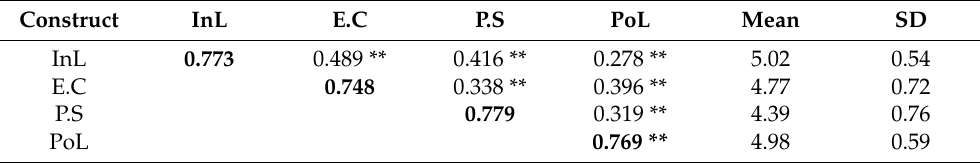
Table 3. Correlations and discriminant validity.